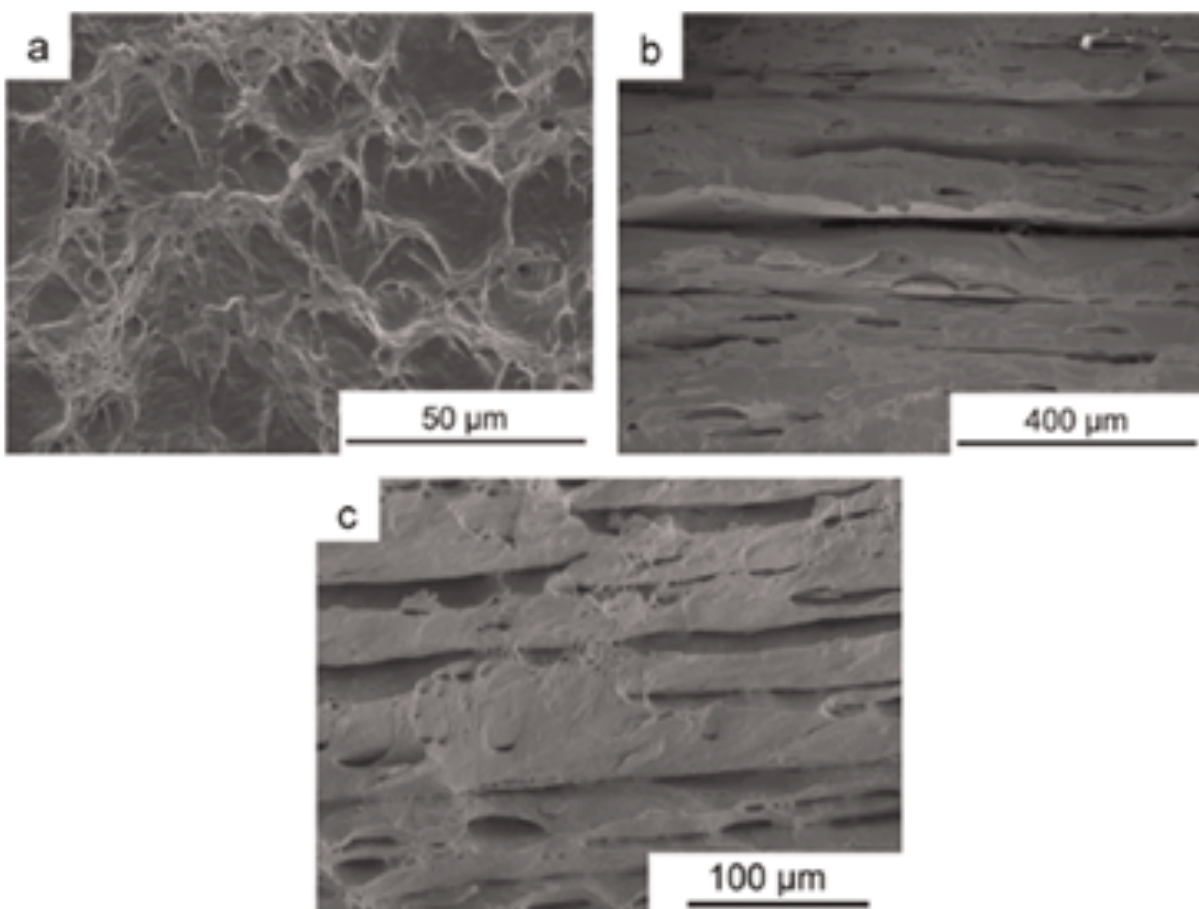
Figure 11: SEM images of tensile fracture of (a) annealed Cu showing ductile features, (b) accumulative roll bonded Cu, and (c) accumulative roll bonded GNS-Cu composite after 6 h rolling, where (b) and (c) show features of shallow dimples and shear zones. Reproduced from Reference